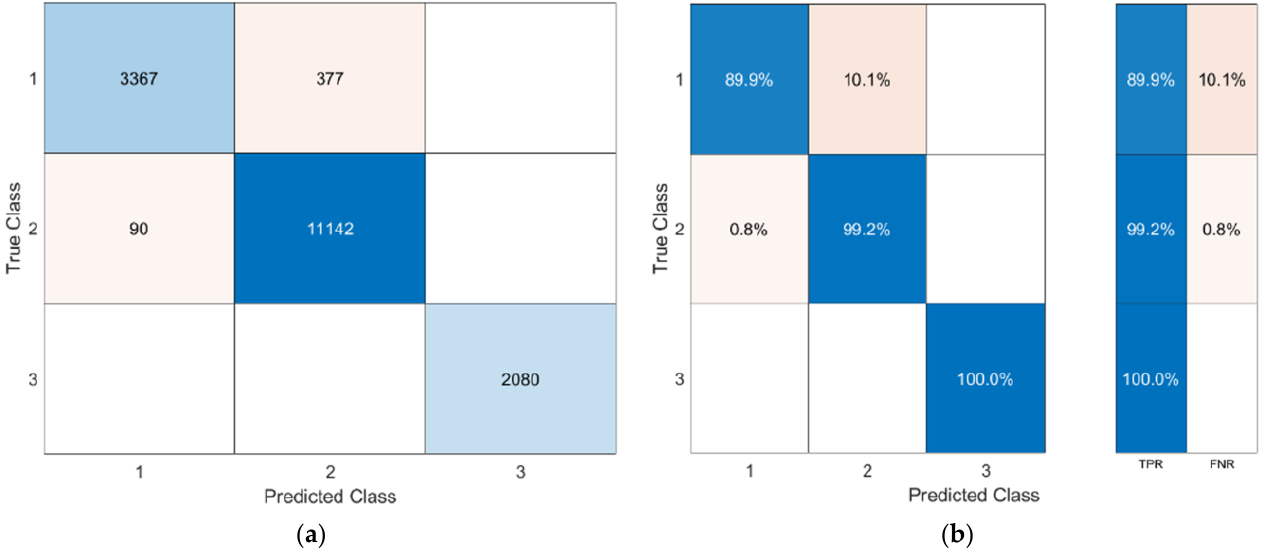
Figure 7. Confusion matrix corresponding to the highest accuracy shown in Table 7: ( a ) confusion matrix showing numerical values ( b ) TPR and FNR (in percentages). Table 8. Performance of fault detection using SFS with RF (five-fold cross-validation). Table 10. Performance of data-mining techniques in fault detection with noisy